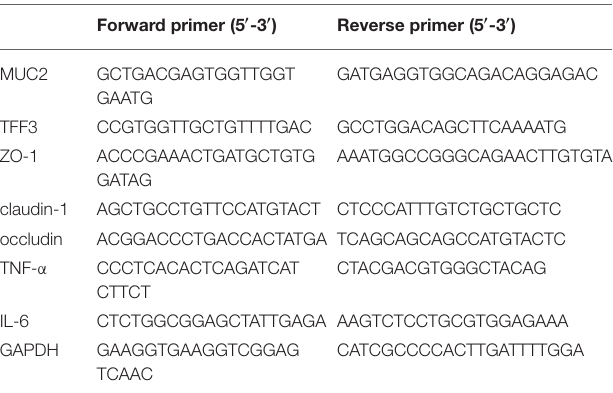
TABLE 1 | Primers used for